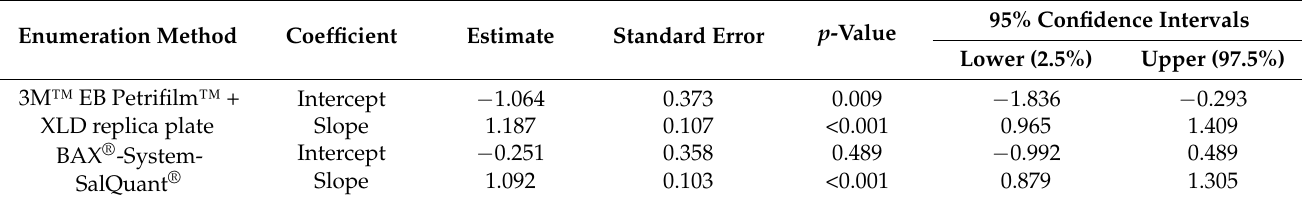
Table 2. Summary table of linear models using the least squares regression method predicting the bacterial counts of 3M™ EB Petrifilm™ + XLD replica plate and BAX ® -System-SalQuant ® when compared with MPN for quantification of Salmonella in beef lymph nodes (n = 25 per